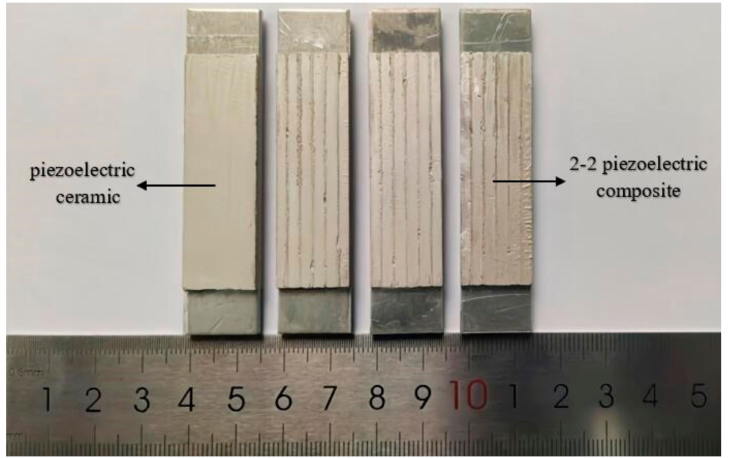
Figure 9. The fabricated trilaminar vibrator